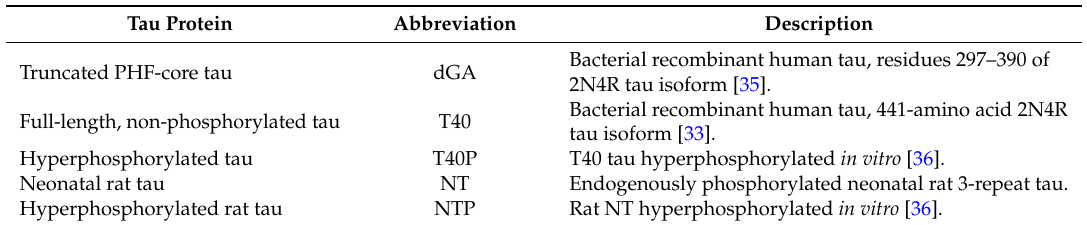
Table 1. Nomenclature for tau